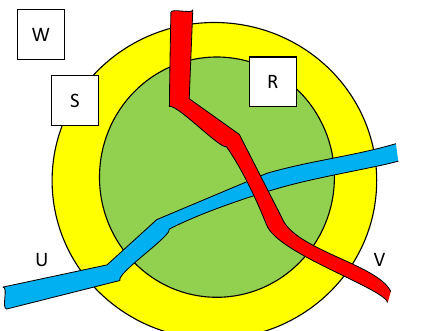
Figure 9. Location of some geographic objects able to influence jurisdiction’s inner dynamics.